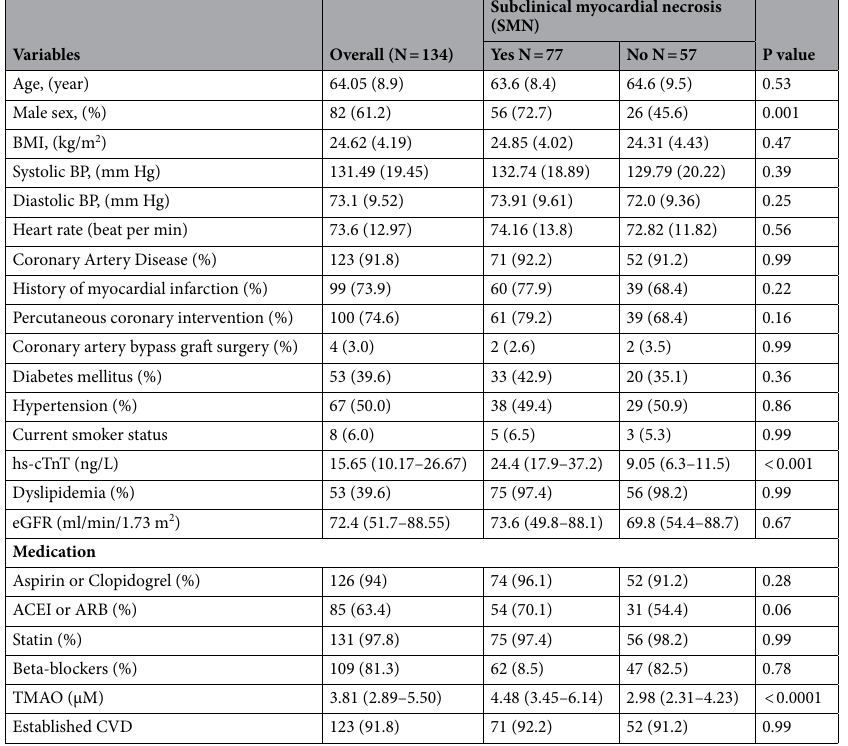
Table 1. Baseline characteristics of study participants. Values are mean ± SD, %, or median (inter-quartile range). ACEI angiotensin converting enzyme inhibitors, ARB angiotensin-receptor blocker, BMI body